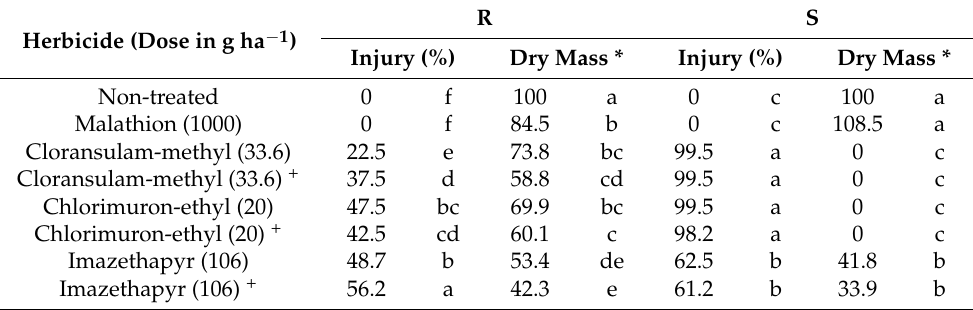
Table 2. Percentages of injury and dry masses at 28 DAA of two Erigeron sumatrensis populations after the application of ALS-inhibiting herbicides with or without the application of malathion. R S Herbicide (Dose in g ha − 1 ) Injury (%) Dry Mass * Injury (%) Dry Mass